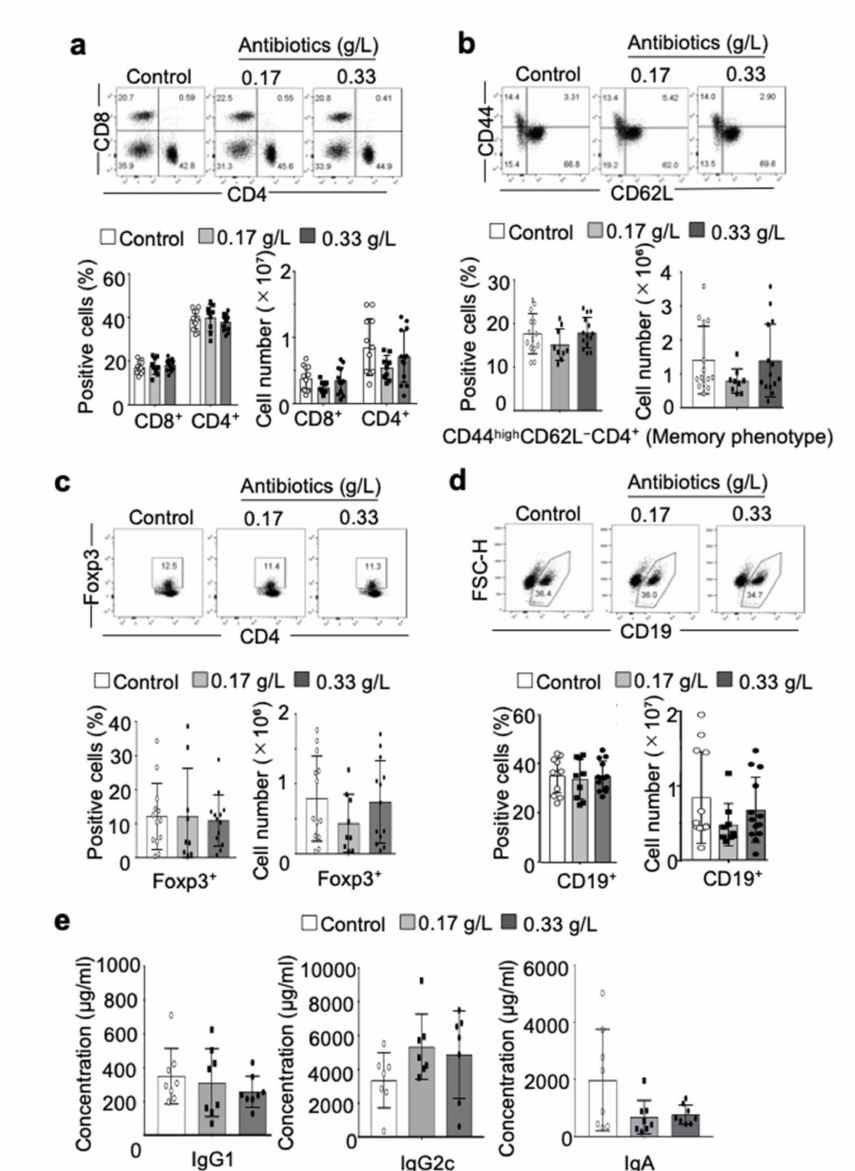
Figure 2. Effect of antibacterial treatment on immune cells. ( a ) T cell populations in the spleen were evaluated and quantified by flow cytometric analysis. Proportion and number of CD4 + or CD8 + T cells were calculated, and data are presented as mean ± SD of 13 mice in control and 0.33 g/L group, 9 mice in 0.17 g/L group. ( b ) Memory phenotype of CD4 + T cells in the spleen was assessed by flow cytometric analysis using anti-CD44 and CD62L antibodies. Proportion and number of CD44 high CD62L − CD4 + T cells were calculated, and data are presented as mean ± SD of 13 mice in control and 0.33 g/L groups and 9 mice in the 0.17 g/L group. ( c ) Regulatory T (Treg) cells in spleen were quantified by flow cytometric analysis using intracellular staining of anti-Foxp3 antibody. Proportion and number of Foxp3 + CD4 + T cells were calculated, and data are presented as mean ± SD of 13 mice in control and 0.33 g/L groups, and 9 mice in the 0.17 g/L group. ( d ) B cells of spleen were evaluated and quantified by flow cytometric analysis. Proportion and number of CD19 + B cells were calculated, and data are presented as mean ± SD of 13 mice in control and 0.33 g/L group, and 9 mice in the 0.17 g/L group. ( e ) Serum IgG1, IgG2c, and IgA were measured by ELISA. Concentration levels of IgG1, and IgA were calculated, and data are presented as mean ± SD of seven or eight mice in each